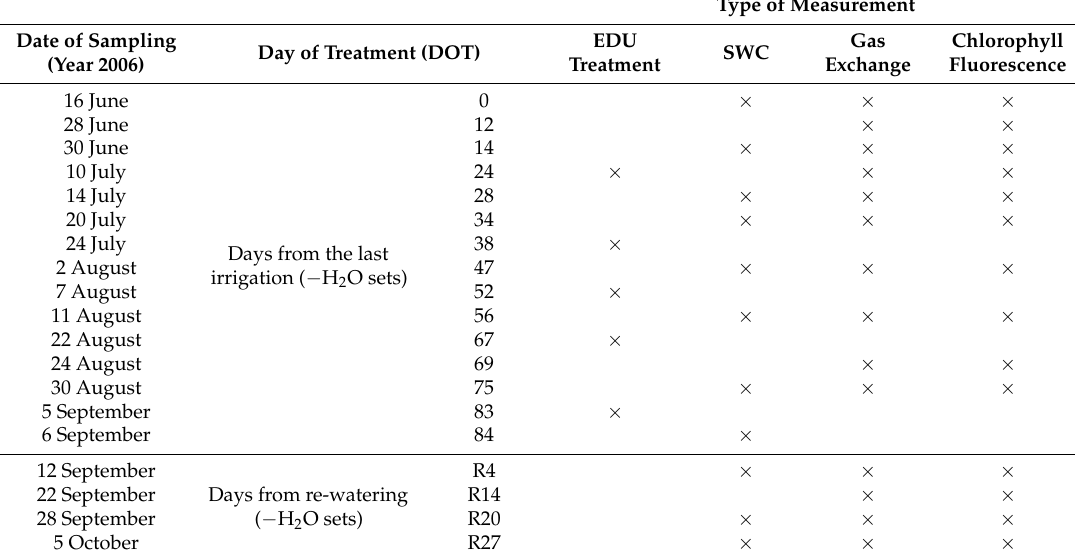
Table 1. Sampling scheme for ethylenediurea (EDU) treatment, soil water content (SWC) and ecophysiological measurements for Fraxinus ornus L. (Manna ash) plants in this study. The × symbol indicates the dates on which each treatment/measurement was carried out. On 10 July (DOT 24), gas exchange and chlorophyll fluorescence were measured before the EDU